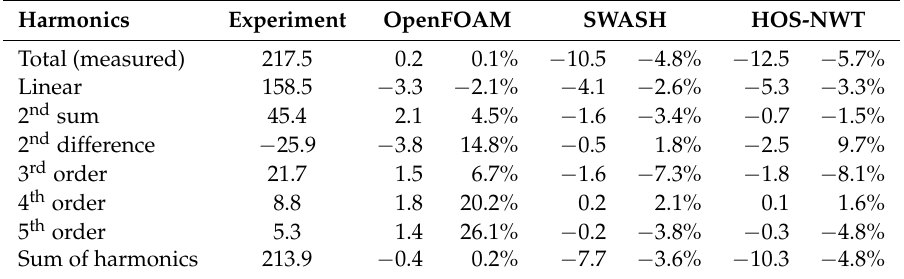
Table 5. Intercomparison of phase-resolving models at the PF location at the crest and through (2 nd diff). The experiment is used as the benchmark and the differences are expressed as absolute (mm) and percentage